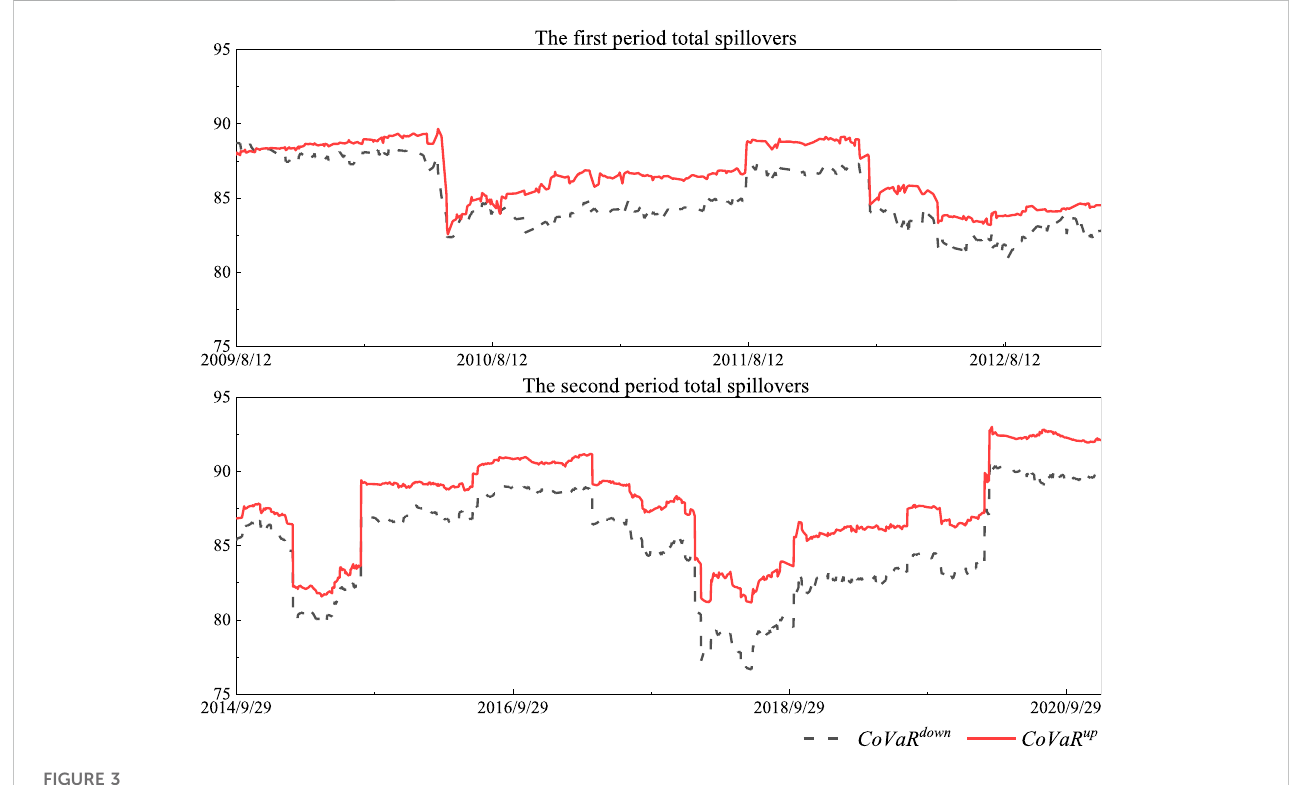
FIGURE 3 Total spillovers. Note: The unit of the vertical axis is